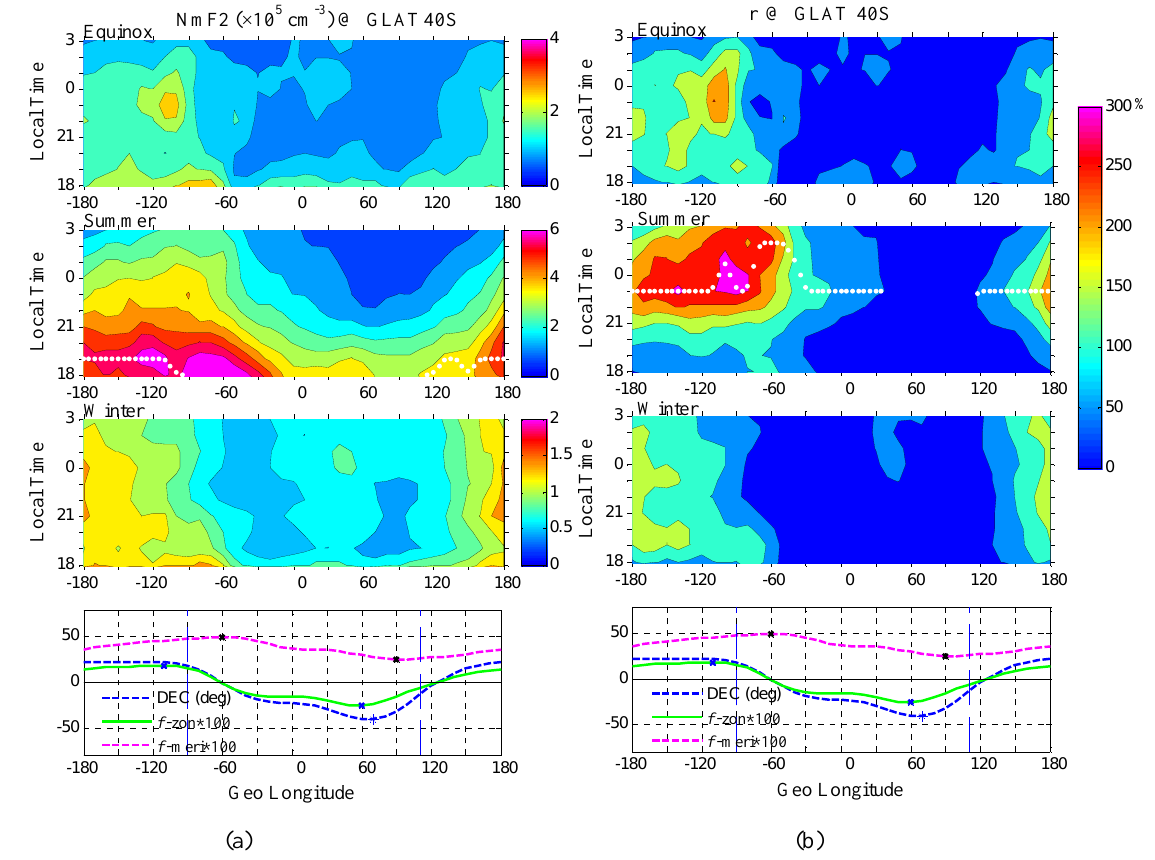
Fig. 1. The longitudinal variations of the absolute (NmF2, left) and relative ( r , right) peak electron density (top three panels) between 18:00 and 03:00LT at 40 ◦ S. The percentage difference r = ( Ne − Ne min )/Ne min · 100% is calculated for each hour of local time. The bottom panels present the magnetic declination angle (DEC, eastward positive) and the contribution factor of f zon (positive for eastward DEC) and f meri (positive) for vertical plasma drifts from the geographic eastward zonal wind and equatorward meridional wind, respectively. The maximum and minimum locations of these factors are also marked. White dots (left) represent the occurrence time of the peak electron density of the WSA, and white dots (right) mark the maximum r value when it is larger than 50%. In the bottom panels, blue dashed lines represent the edges of the longitudes where the WSA occurs at this particular latitude. Note that the electron density scales are different in different seasons. See the text for more detail.